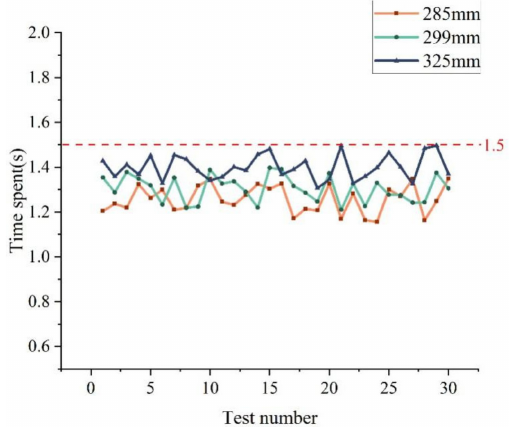
Figure 17. Time-consumption-record